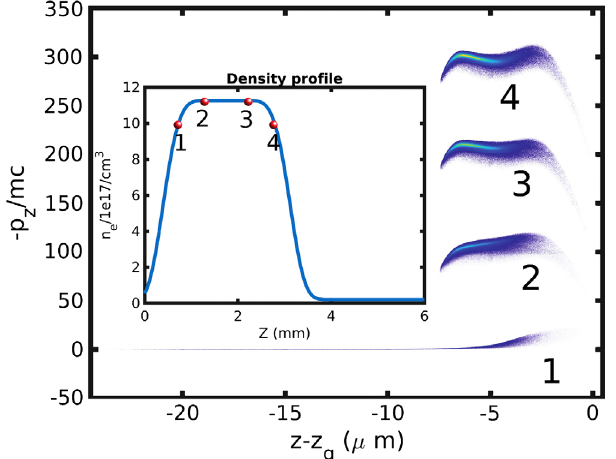
FIG. 6. Sequence of longitudinal phase-space densities in four distinct interaction points. Inset: background plasma density profile and position of the